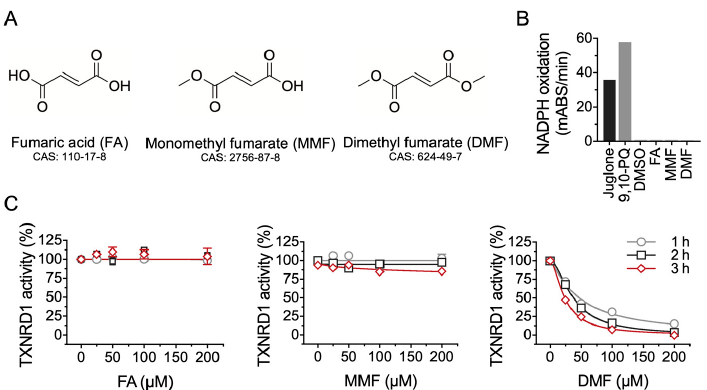
Figure 1. DMF is an inhibitor of TXNRD1. ( A ) Chemical structures of FA, MMF and DMF. ( B ) NADPH oxidation activity of TXNRD1 using various compounds as electron acceptors. 30 μ M juglone and 30 μ M 9,10-PQ were used as positive controls in this experiment. FA, MMF and DMF were included for testing. The final mixture solution contained 30 nM TXNRD1, 200 μ M NADPH and 200 μ M compounds. ( C ) Dose- and time-dependent inhibition of DMF on TXNRD1. Rat TXNRD1 was incubated with FA, MMF and DMF for the indicated time. The TXNRD1 activity was assayed by classic DTNB reducing activity assay. Data are presented as mean ± SEM with three independent